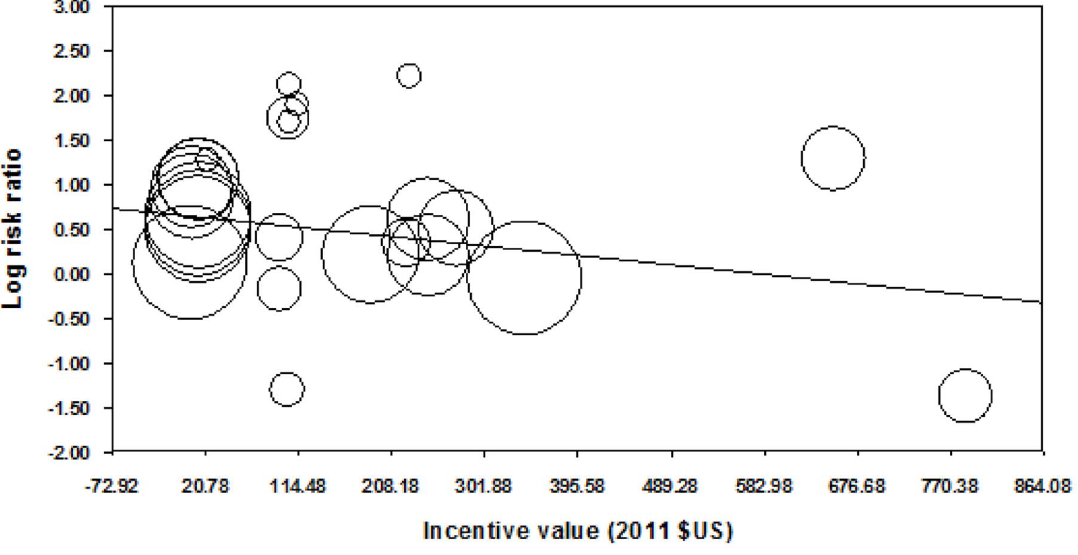
Figure 16. Meta-regression of incentive value on relative risk, all behaviours (latest follow-up point).